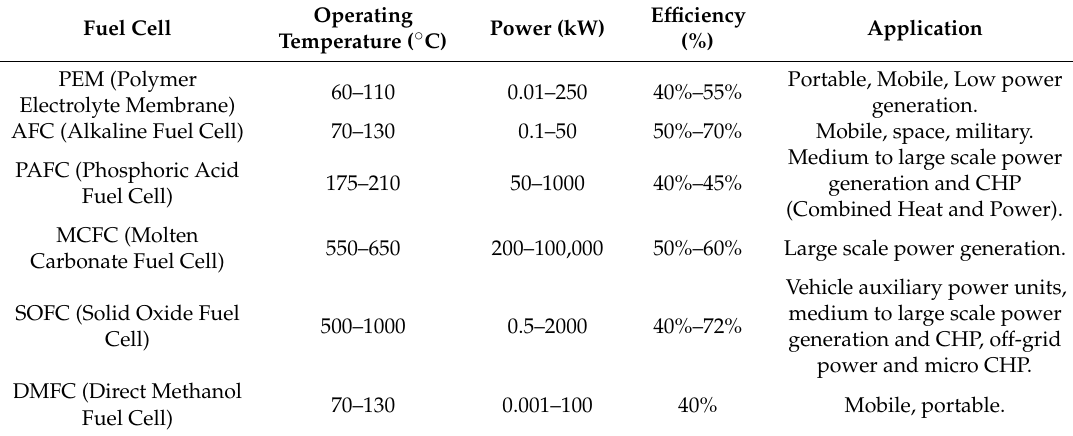
Table 1. Comparison of different types of Fuel